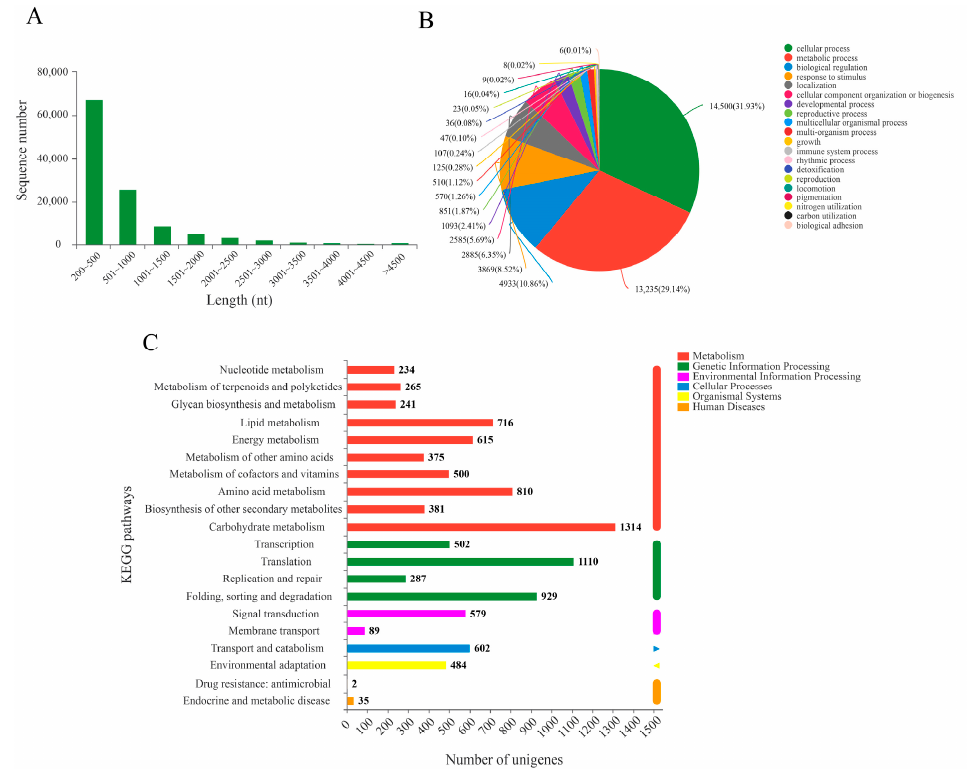
Figure 1. Functional annotations of the unigenes of the P. ternata bulbil transcriptome. ( A ) length distribution of assembled unigenes; ( B ) GO function annotation of P. ternata ; ( C ) KEGG function annotation of P. ternata .